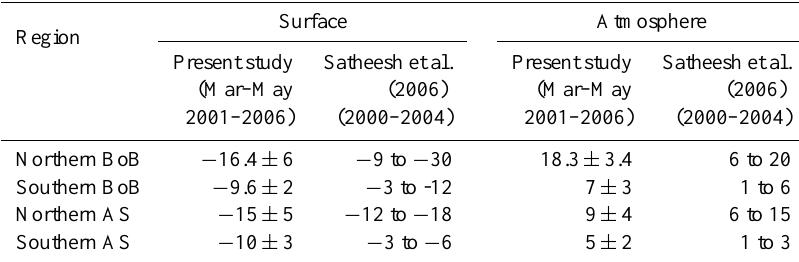
Table 9. Comparison of model-simulated multi-year mean all-sky aerosol radiative forcing and reported all-sky forcing from Satheesh et al. (2006) over northern and southern BoB and AS regions.